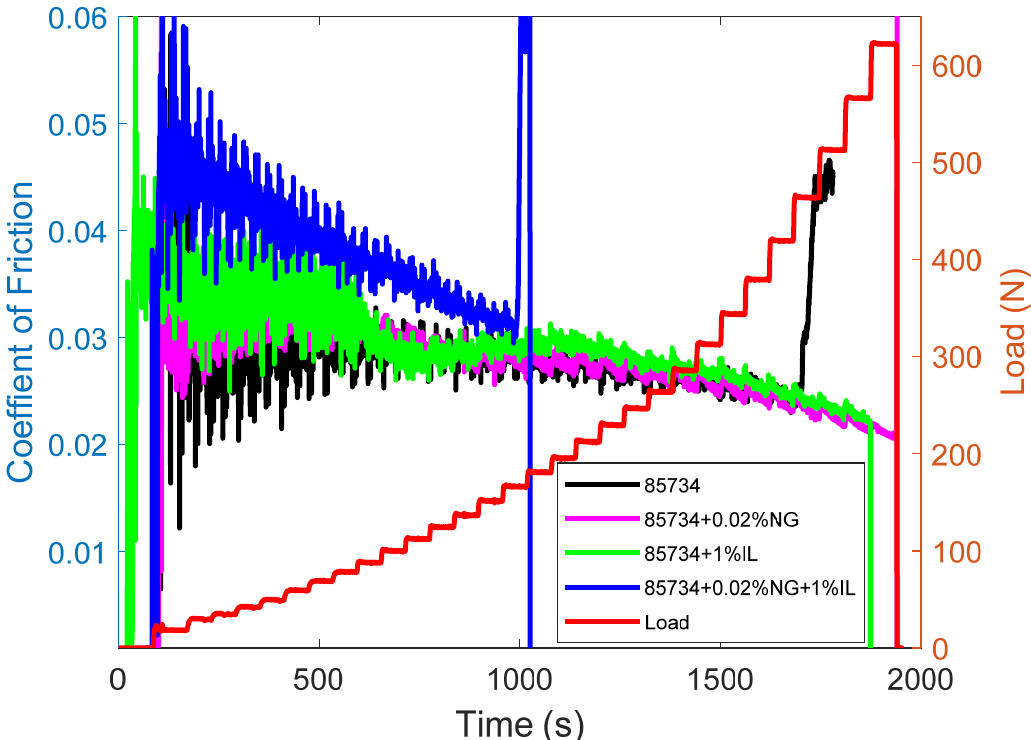
Figure 5. COF and applied load during scuffing load experiments.